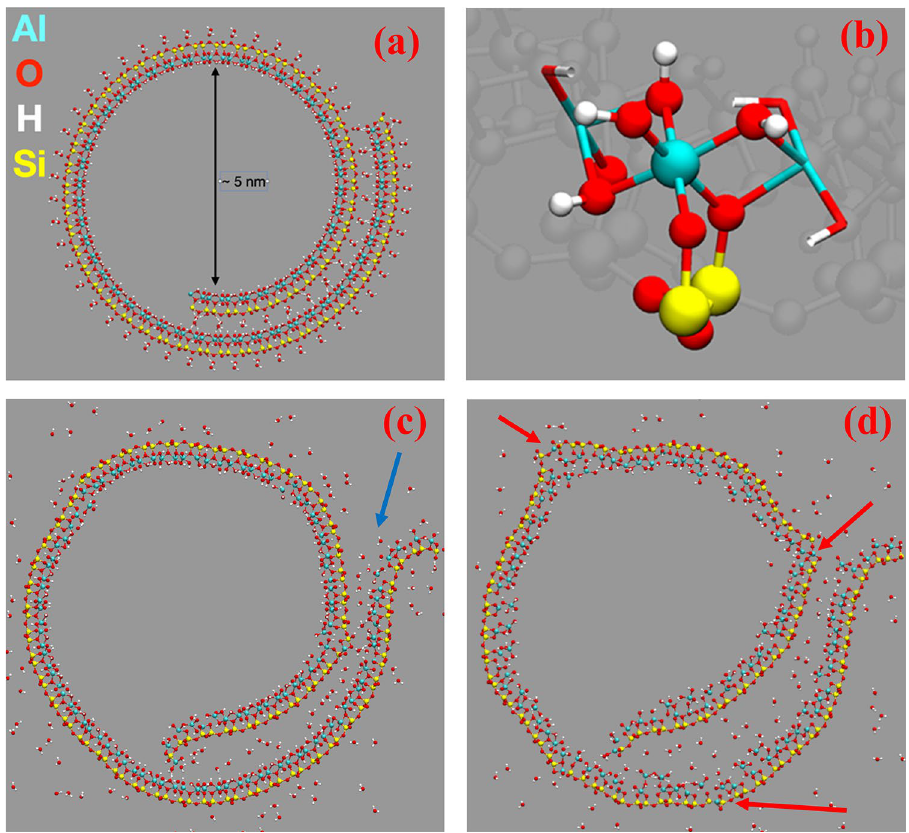
Figure 1. In ( a ), the optimized spiral HNT structure. In ( b ), a zoom on the structure showing the coordination of Al with 4 hydroxyl group and two –O–Si-. In ( c ) and ( d ), the structure at 300 and 800 K, respectively, after ~ 10 ps molecular dynamics. Atom color code Al (cyan), Si (yellow), O (red), and H (white). The blue arrow highlights the unfolding of the HNT spiral, the red ones the break of the HNT